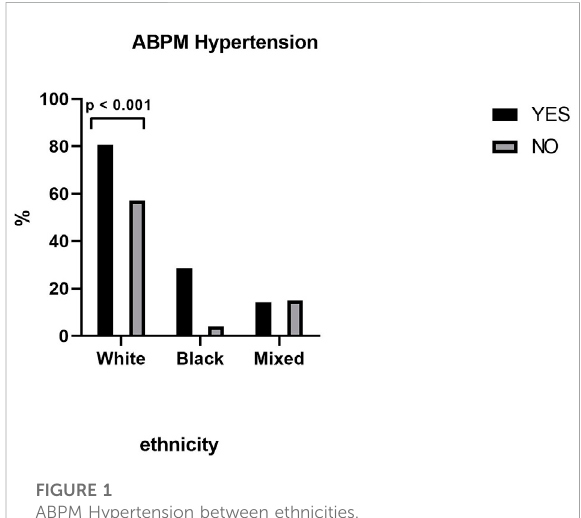
FIGURE 1 ABPM Hypertension between